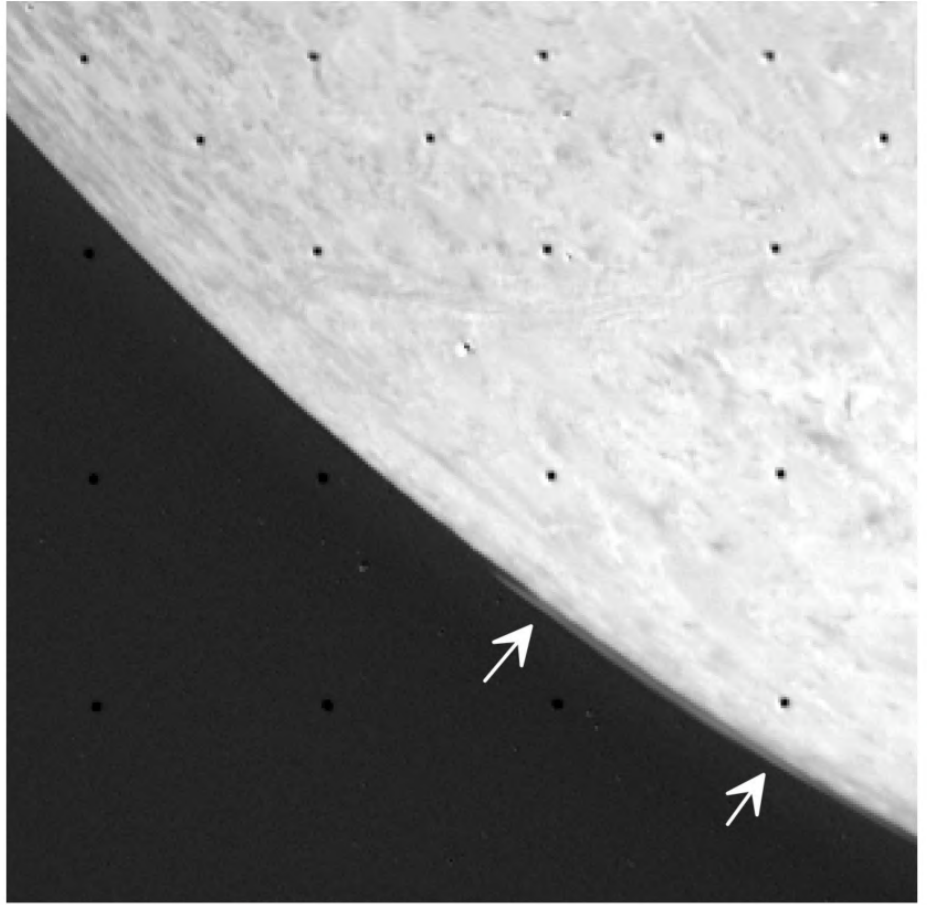
Figure 4. Limb image of Triton showing a detached haze layer (arrows) at least 5–7 km above the surface. Image number c1139427.imq. Nominal pixel scale of 1 km, haze centered at ~30 ◦ S, 300 ◦ E. Surface is brightened to enhance lack of limb relief. Area dominated by cantaloupe terrain and several linear ridges. South is to